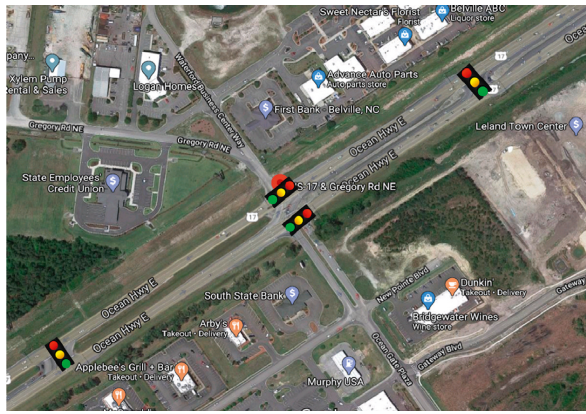
Figure 1: Selected superstreet for the case study and signal locations (adapted from the screenshot of google maps).